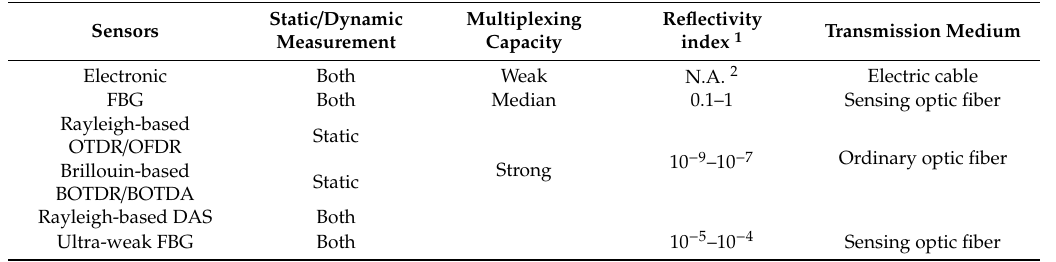
Table 1. Comparisons between common sensors for underground structure monitoring and ultra-weak fiber Bragg grating (FBG).